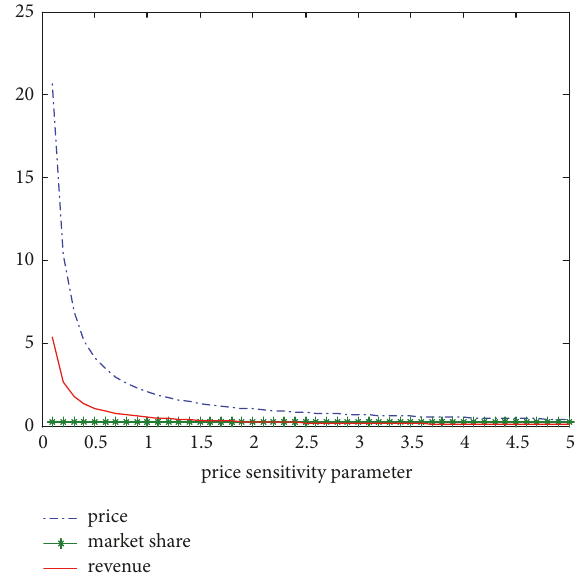
Figure 3: The variation of optimal solutions with the price sensitiv- ity